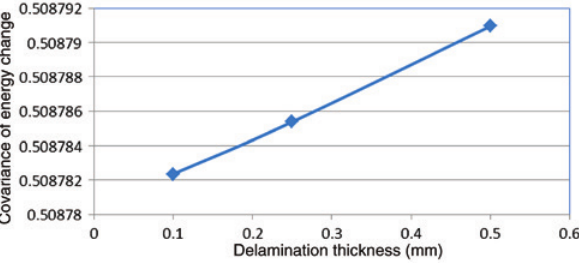
Figure 18: Covariance of energy change with varying delamination thickness size at Section 1.